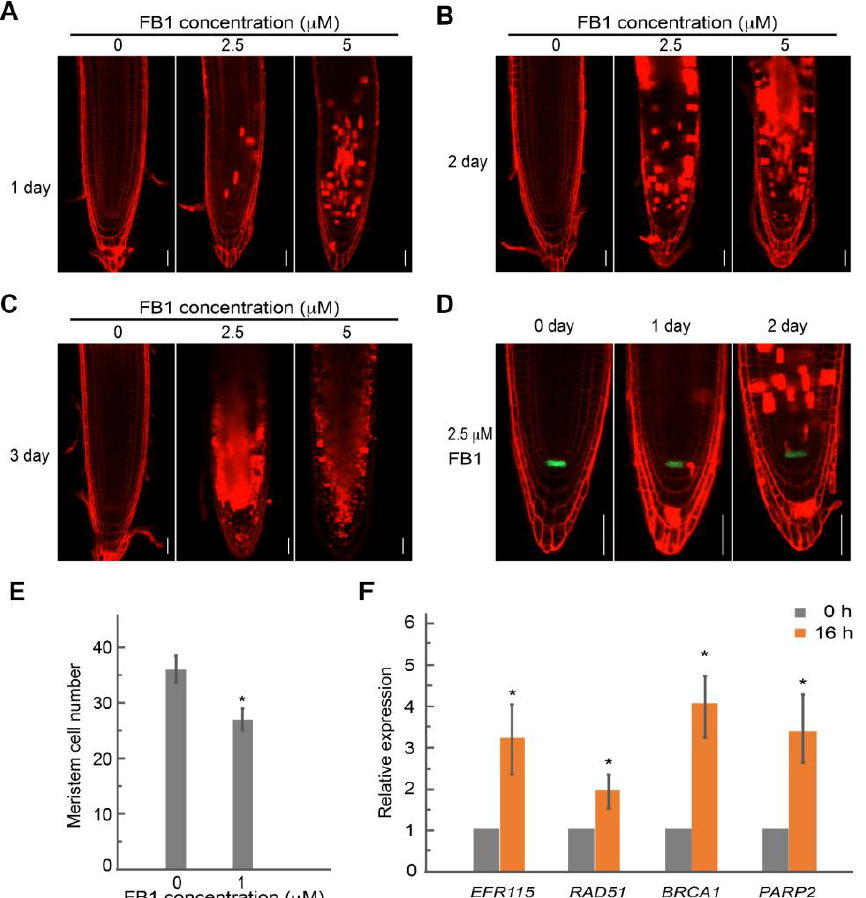
Figure 4. FB1 induces cell death in the root apical meristem. The root tips were stained with PI (red). ( A ) to ( C ) Confocal images of wild-type seedlings treated with FB1 at different concentrations (0, 2.5, or 5 µ M) for ( A ) 1 day, ( B ) 2 days or ( C ) 3 days. ( D ) Fluorescence pattern of WOX5pro:ERGFP (green) in wild-type root tips treated with 2.5 µ M FB1 for 0, 1, or 2 days. ( E ) Root meristem cell number of wild-type seedlings treated with 1 µ M FB1 for 3 days. ( F ) Relative transcript levels of DNA damage response genes in wild-type seedlings treated with 2.5 µ M FB1 for 0 or 16 h, as determined by RT-qPCR analysis. Data are means ± SD. Asterisk (*) denotes significant difference relative to seedlings without FB1, as determined by t -test; p < 0.01. Scale bars, 50 μm.